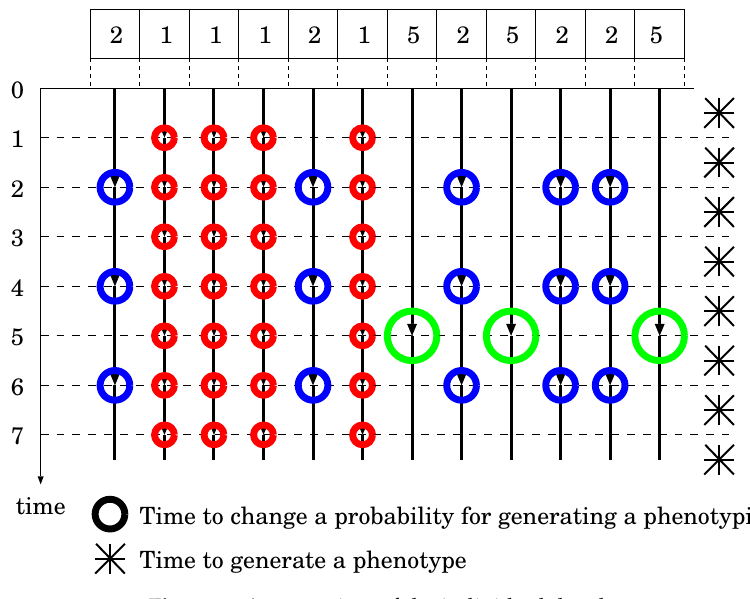
Figure 1. An overview of the individual